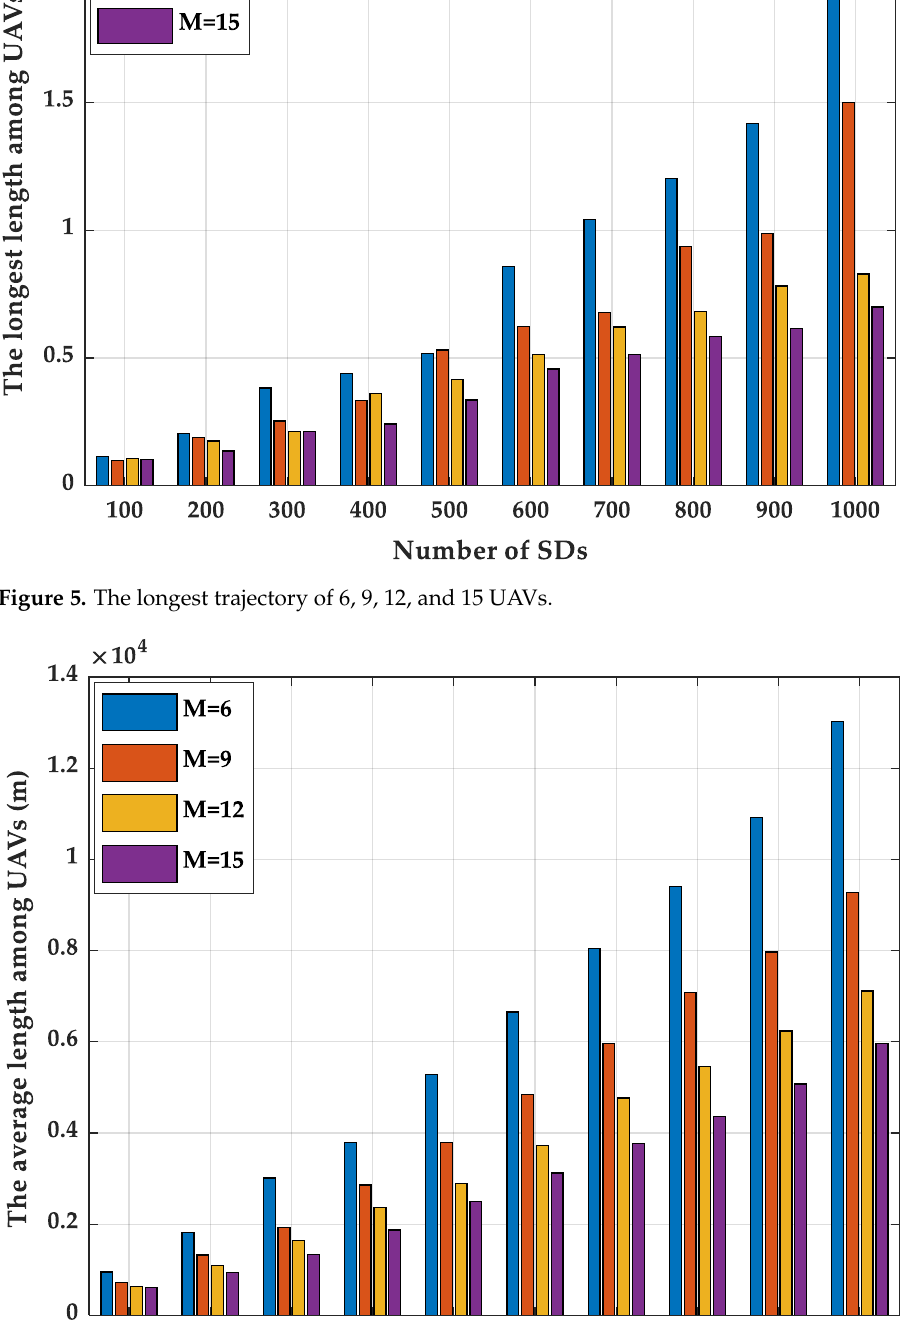
Figure 7. The average time delay of 6 UAVs with different algorithm. Table 5 demonstrates the optimal value, worst value, mean value and median value of the energy efficiency of the longest trajectory under 20 scenarios. Due to space limita- tion, only the optimal and median values of the two comparison algorithms are given. In